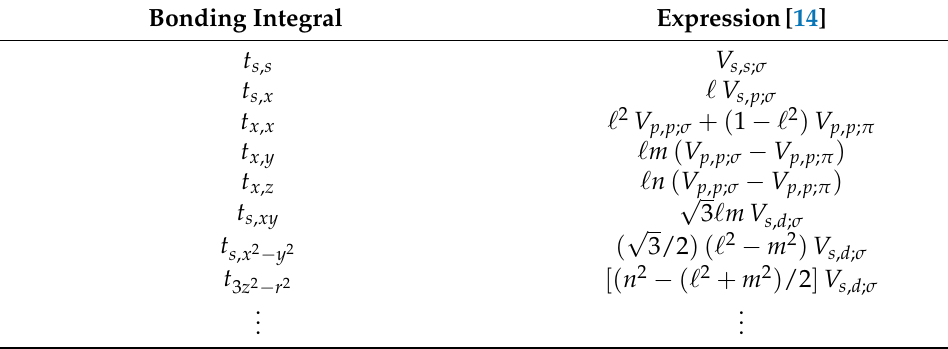
Table 2. Expressions for Bonding